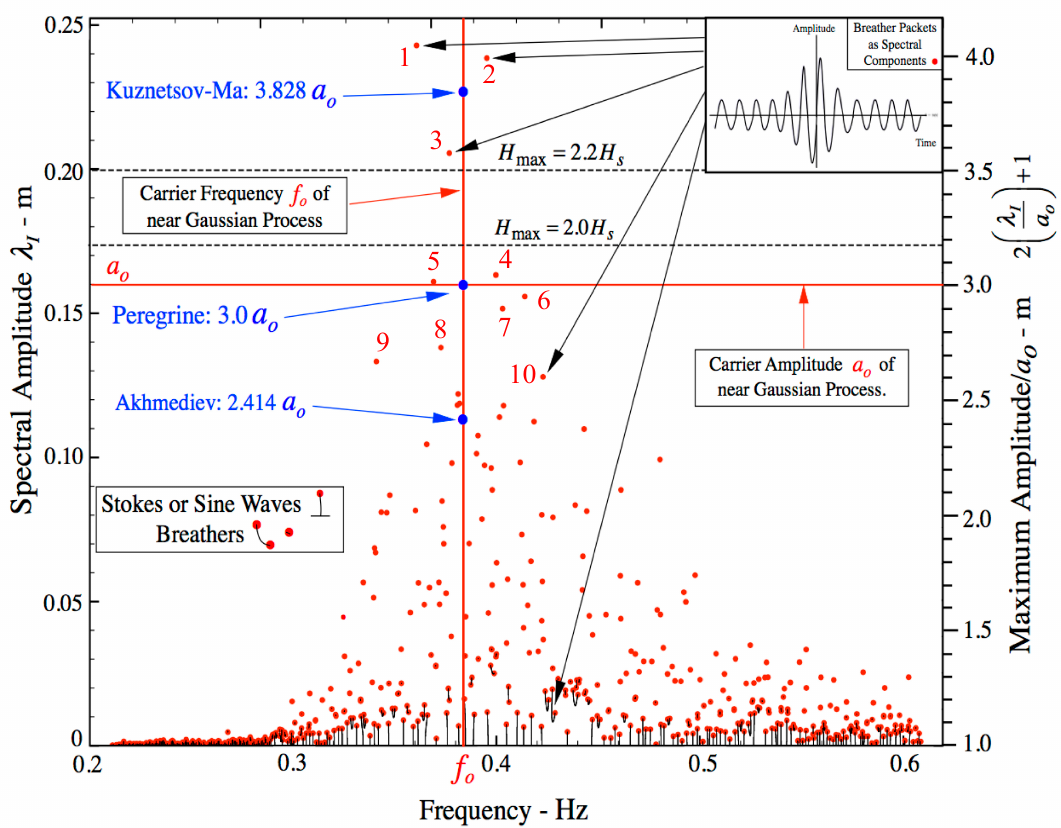
Figure 30. The nonlinear Fourier (NLFA) spectrum for the complex modulation function obtained from the time series in Figure 29. Note that there are two vertical axes. The one on the left is the actual eigenvalue obtained in the computation of the NLFT spectrum and has units of meters. The right-hand vertical axis is dimensionless, and it is effectively the maximum amplitude of a breather normalized by the carrier amplitude. This means that the actual carrier amplitude a o = 16 cm (left vertical axis, see the horizontal red line a o and see horizontal red line in Figure 29) and the normalized amplitude is 3 (see the right-hand vertical axis). The actual positions of the three theoretical breathers most often cited (Akhmediev, Peregrine, and Ma–Kuznetsov) are shown in blue. Spectral data points above 2.2 H s (there are three of them) are considered to be rogue waves. The red numbers labeling the ten largest breather packets coincide with the ten largest packets of the time series in Figure 29.